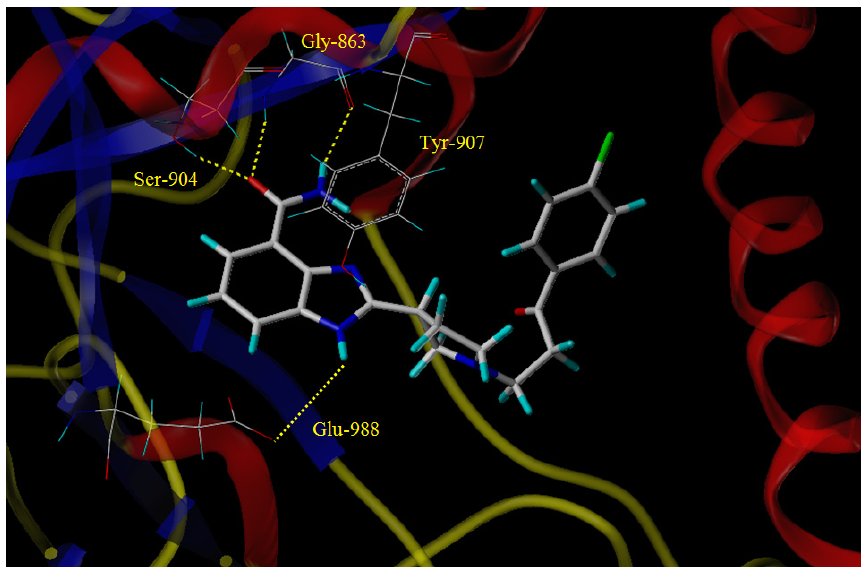
Figure 3. Molecular docking of 5cj with PARP-1.